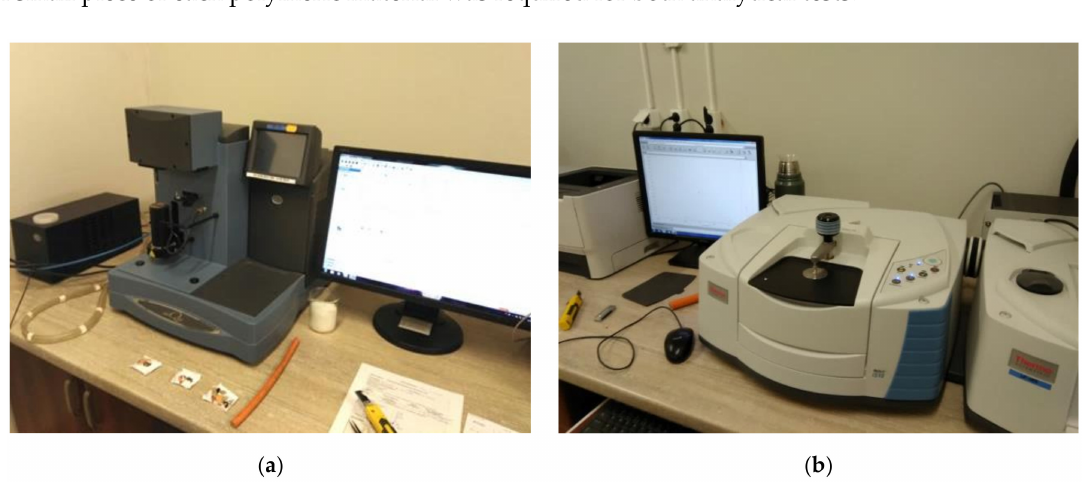
Figure 3. Small-scale instrumental equipment at the accredited ITB Fire Laboratory, Poland: ( a ) TGA; ( b )